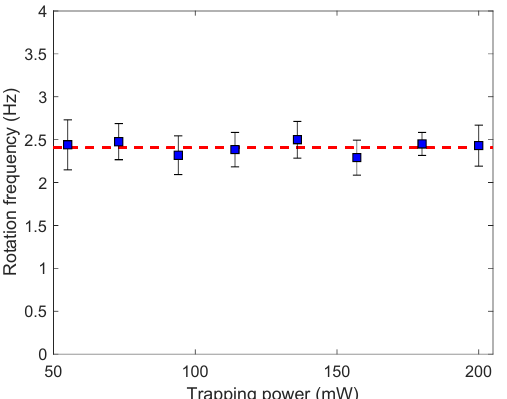
Figure 5. Rotation frequency of Dunaliella as a function of the trapping power. The dashed line is the average rotation frequency of the detached Dunaliella for the whole range of optical